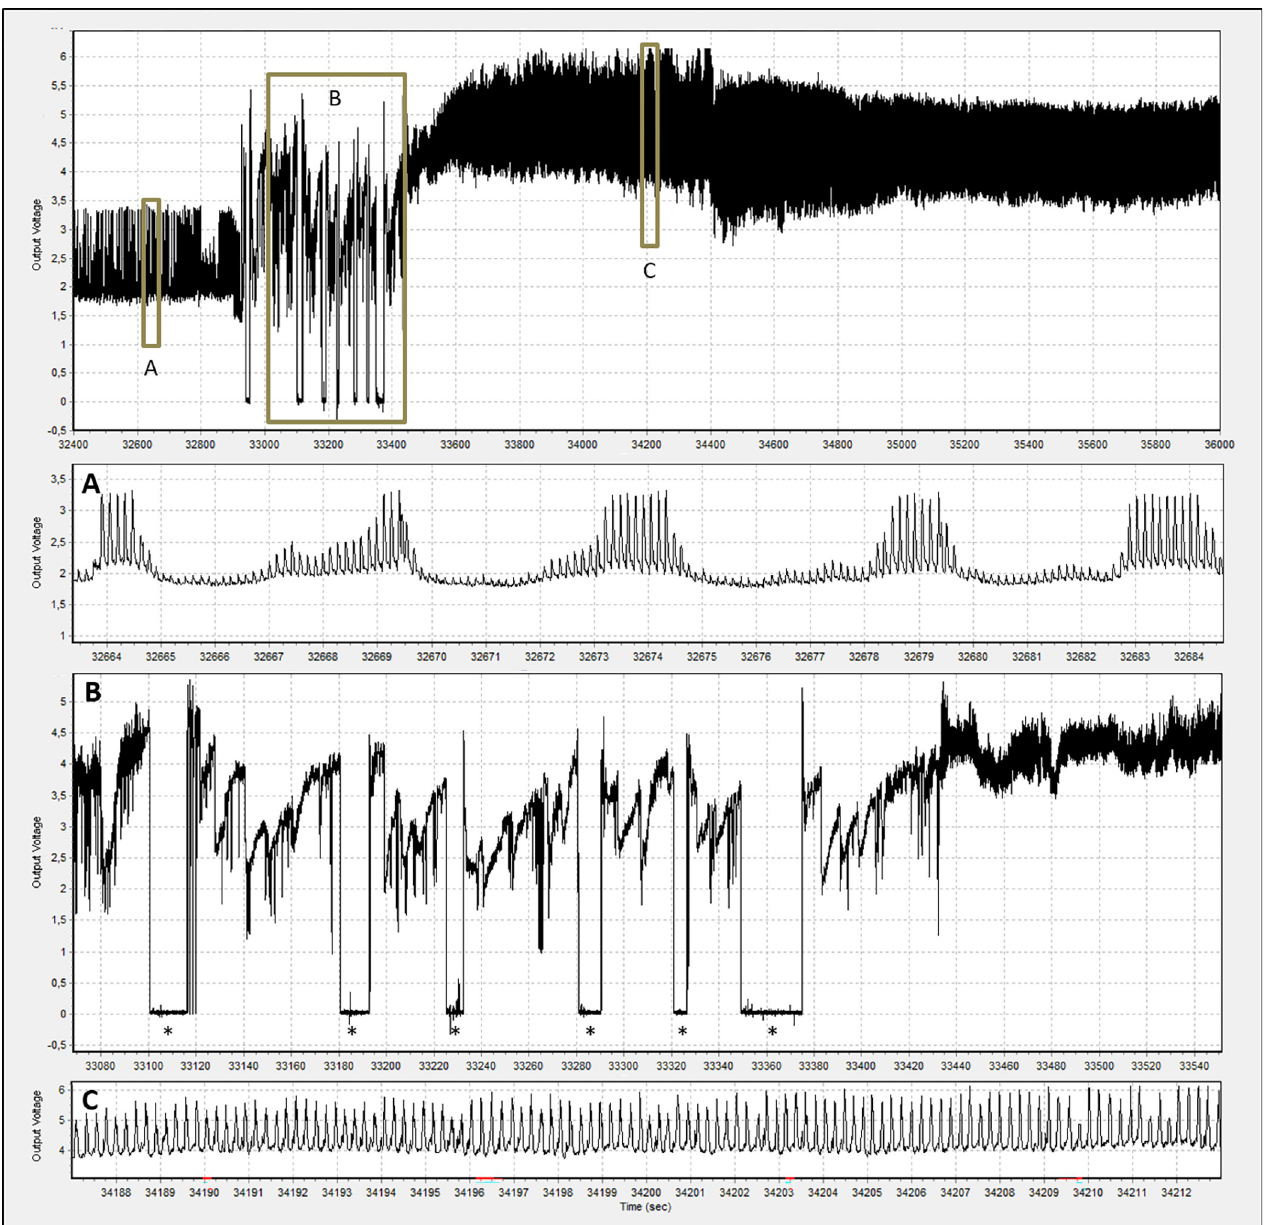
Fig 1. Samples of some major waveforms displayed during probing of D . maidis females. A: phloem ingestion (Dm5). B: a series of five short probes with stylet pathway (Dm1) waveforms only, combined with brief non-probing periods (NP) ( � ), followed by a longer probe in which the insect began to ingest from xylem (Dm2) (at around 33440 sec). C: xylem ingestion (Dm2). The X axis indicates the time (seconds) from the beginning of the recording session.